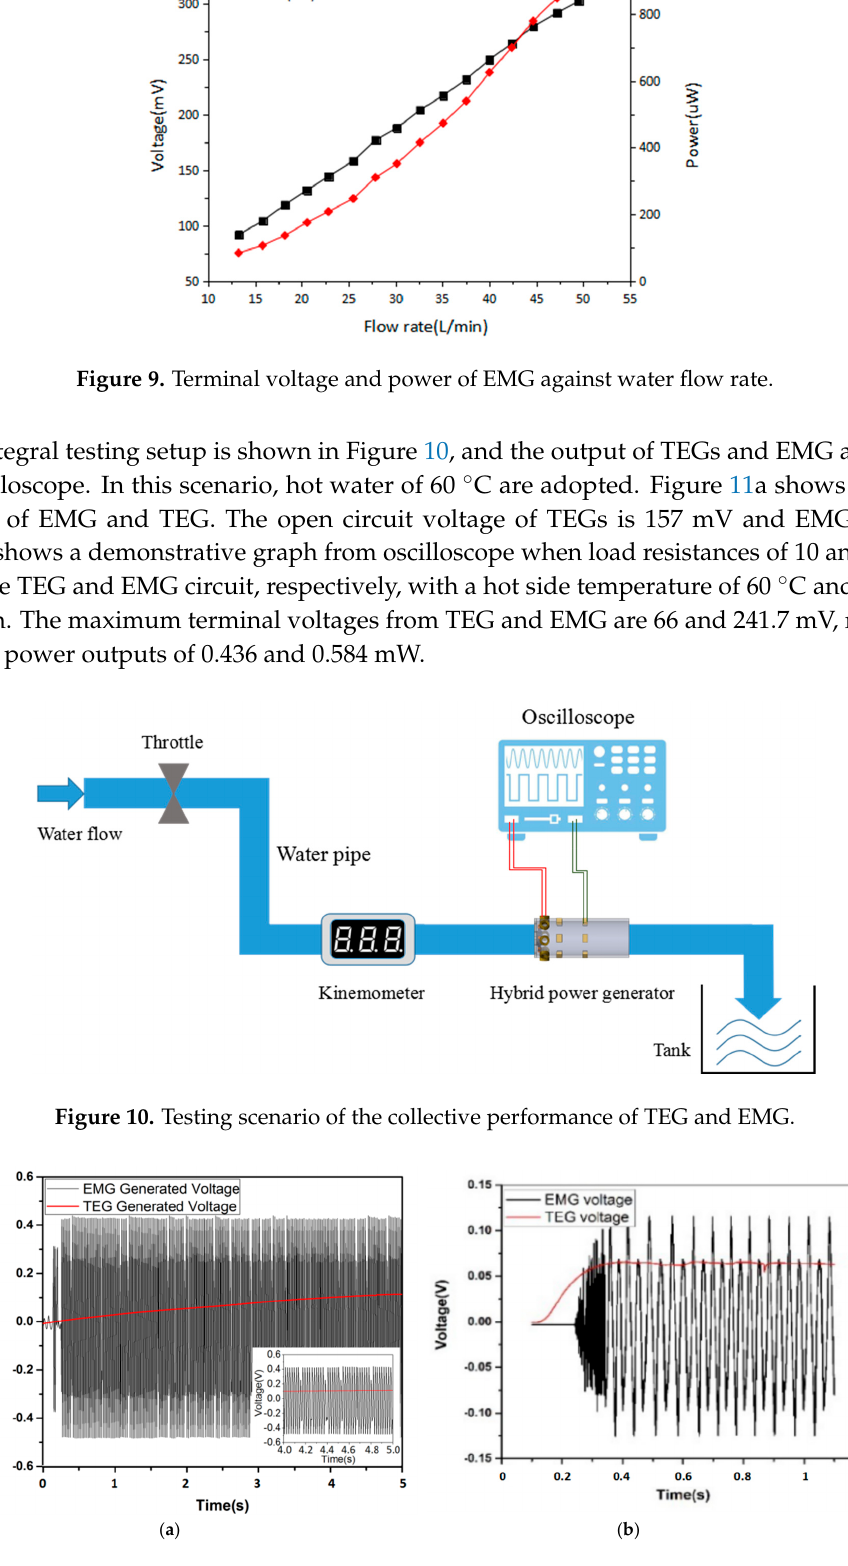
Figure 11. ( a ) Collective open circuit voltage of EMG and TEG; and, ( b ) Collective output voltage of TEG and EMG under load resistance of 10 and 100 Ω .